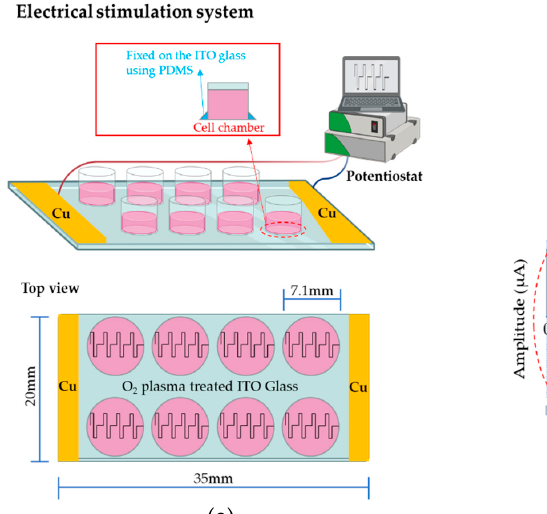
Figure 7. The four different electrical stimulation conditions (experimental group) employed in this study. 3.4. Cell Culture To maintain self-renewing hADMSCs, cells were cultured in basal medium (BM). The cells were seeded at a density of 5000 cells/cm 2 . When the hADMSCs reached approximately 70–80% confluency, the cells were subcultured, and the medium was changed every 2–3 days. To electro stimuli the hADMSCs, the basal medium (BM) was replaced with osteogenic differentiation medium (OM), the supplements of which are shown in Table 1. The differenti- ation procedures are shown in Figure 8. The BM and OM contained 10% FBS and 1% PS, and